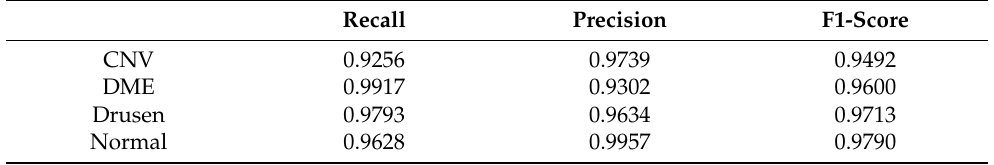
Table 5. CNN model with 5 hidden